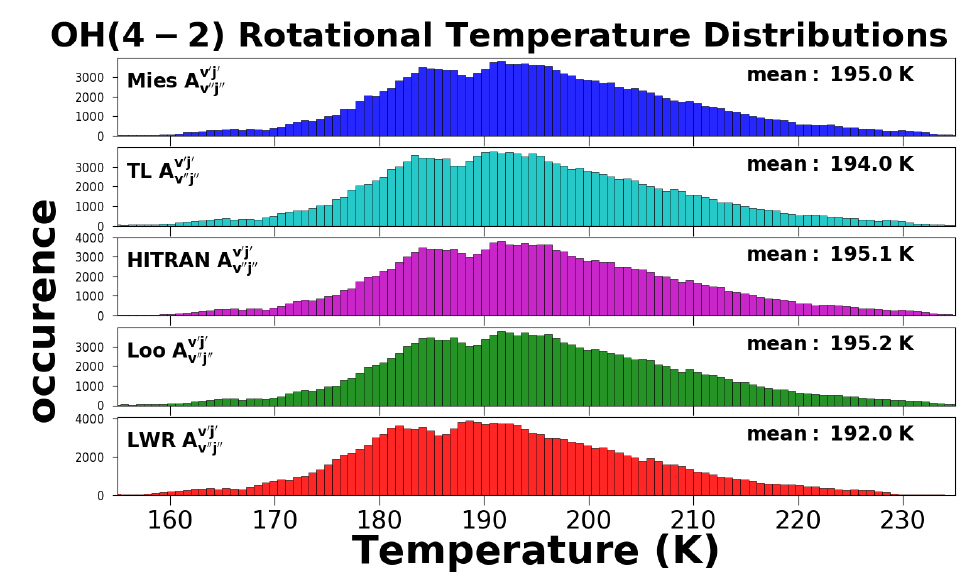
Figure 2. APOGEE OH ( 4 − 2 ) rotational temperature distributions versus Einstein A coefficients.